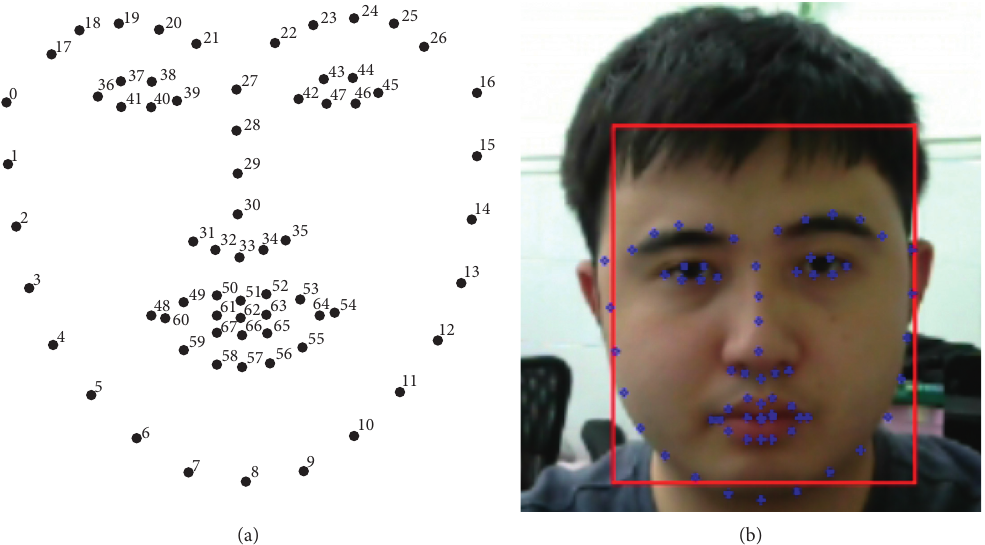
Figure 4: Driver’s face feature point acquisition based on Dlib. (a) Dlib face feature point positioning. (b) Face feature point positioning effect.